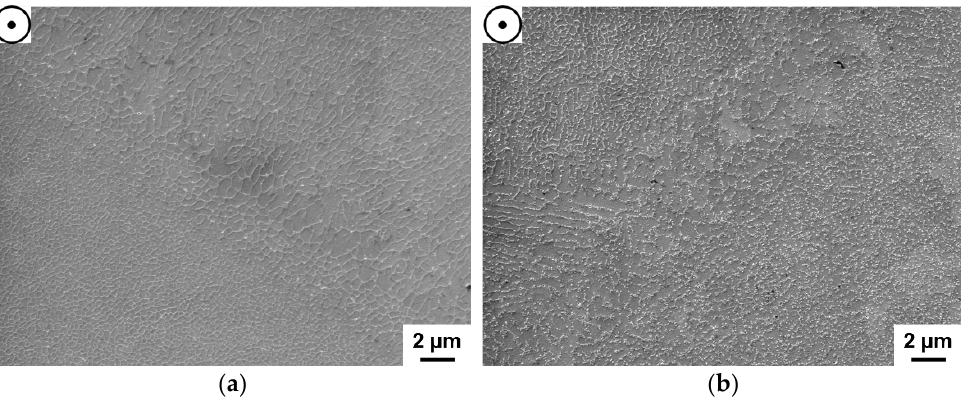
Figure 13. Microstructures of samples heated at 5 °C/min until ( a ) 230 °C and ( b ) 320 °C followed by water quenching (XY cross-section; SEM, x10000, 15 kV, 11 mm, 80 pA, SE).